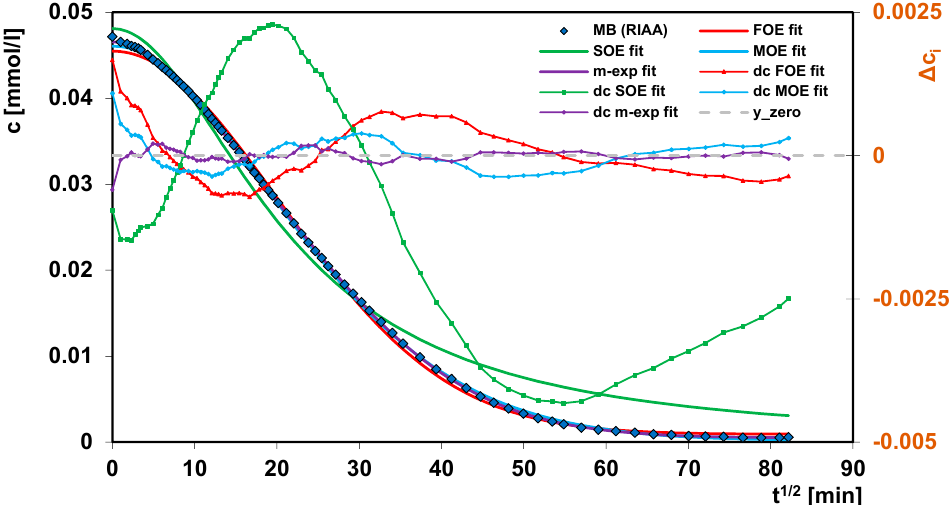
Figure 12. Comparison of the adsorption kinetics for methylene blue on the activated carbon RIAA fitted to the FOE, SOE, MOE and m-exp. equations.